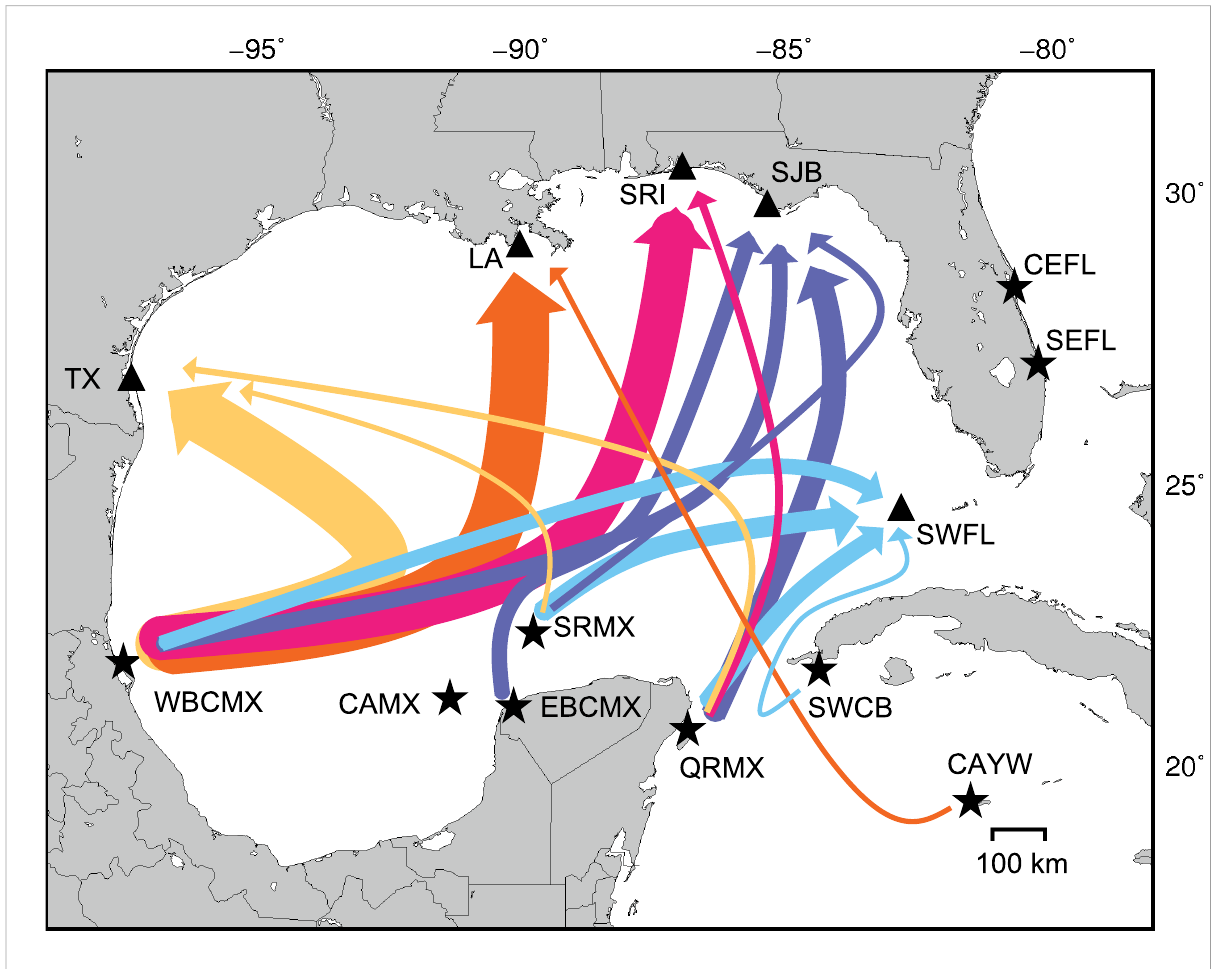
FIGURE 3 Median estimated rookery contributions to fi ve Gulf of Mexico neritic juvenile foraging aggregations based on Bayesian many-to-one (foraging- centric) mixed stock analyses assuming uniform priors. Line thickness indicates the relative magnitude of inferred connectivity between nesting populations and juvenile nursery habitats. Estimated contributions < 0.05 were excluded for legibility. DTFL was included in mixed stock analyses but excluded for legibility. Site codes are explained in Figure